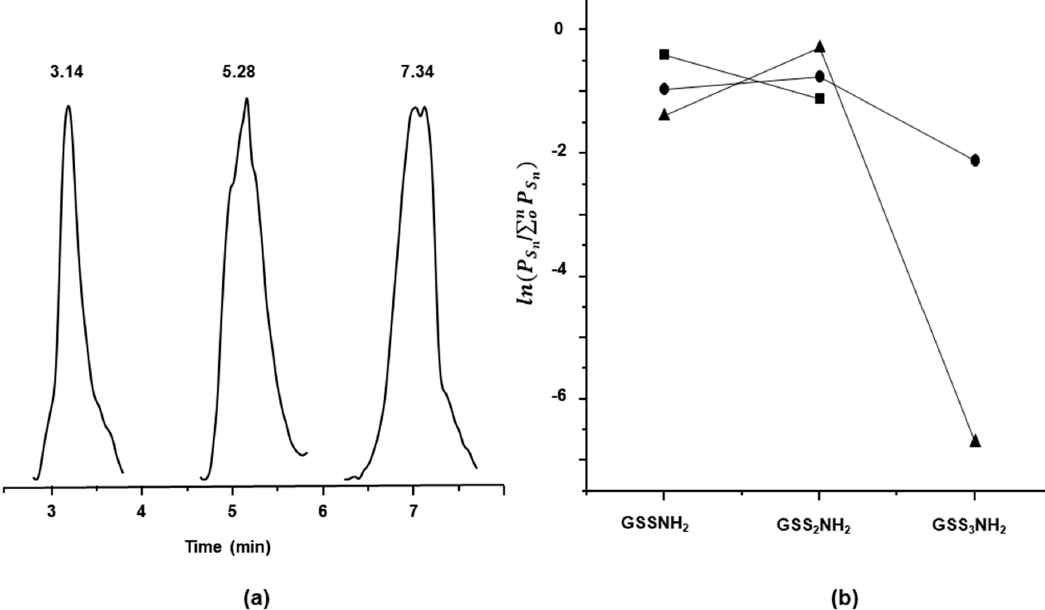
Figure 7. ( a ) Normalized SICs of glutathione sulfonamide GSS n NH 2 in the reaction of GSNO (1 mM) with Na 2 S in iP buffer at pH 7 and ( b ) relative distribution as calculated from the peak area of the SICs for reactions at Na 2 S ratios of (square) 0.25, (circle) 0.5, (rectangle), 1 mM.